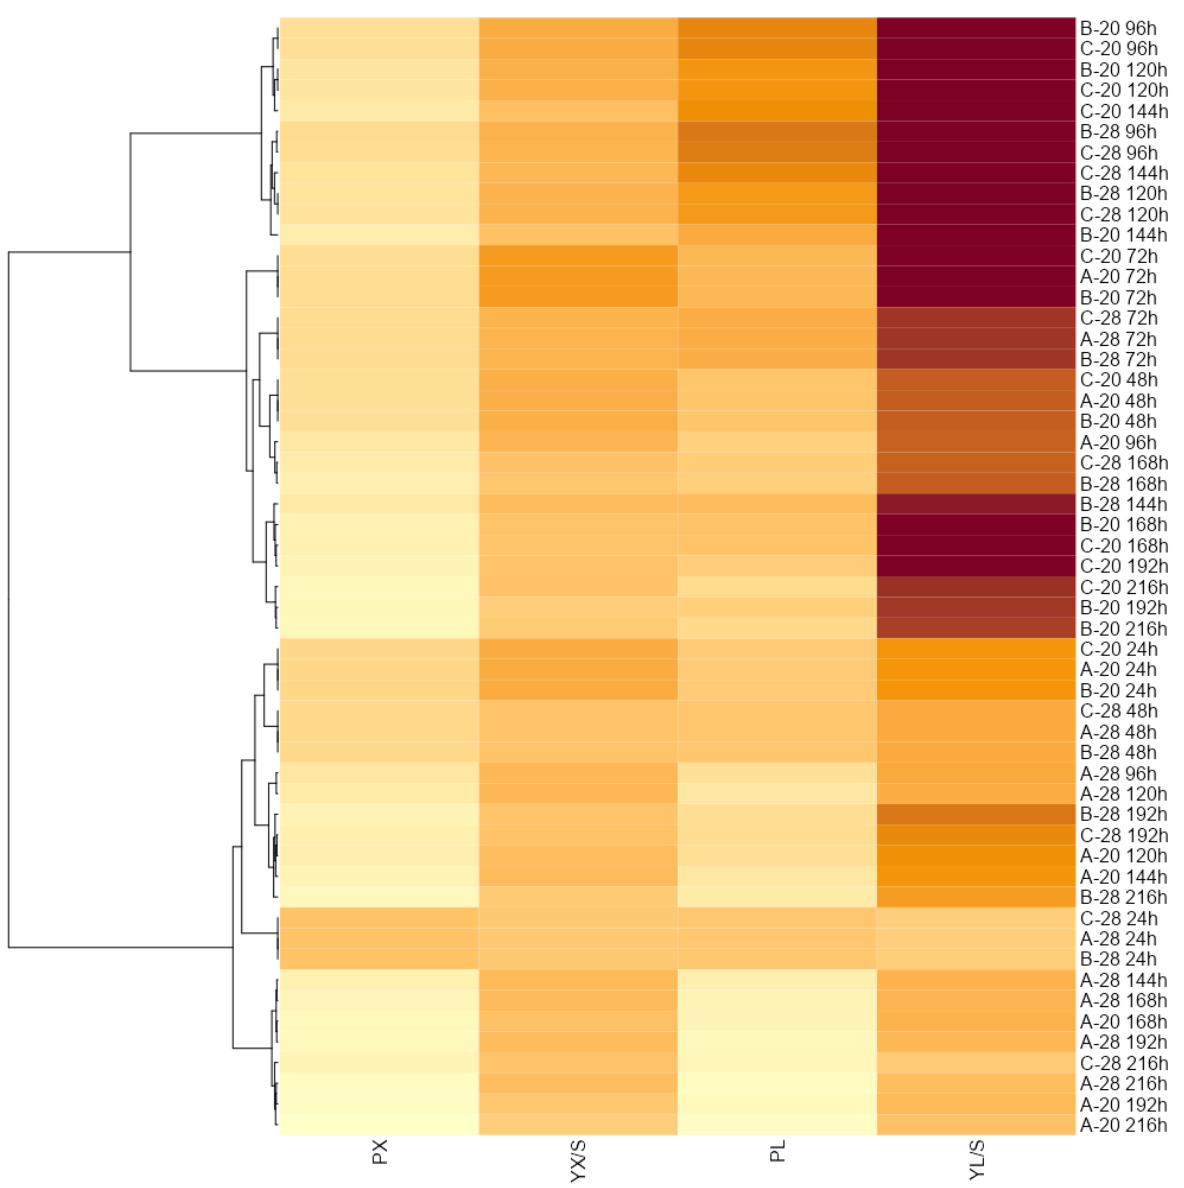
Figure 4. Heatmap based on productivity of biomass (P X ), biomass/glucose yield coefficient (Y X/S ), lipids productivity (P L ), and lipid/glucose yield coefficient (Y L/S ) at different batch types (A, B, C), temperatures of incubation (20 – 28 °C), and times of cultivation (24 – 216 h) ( p < 0.05).